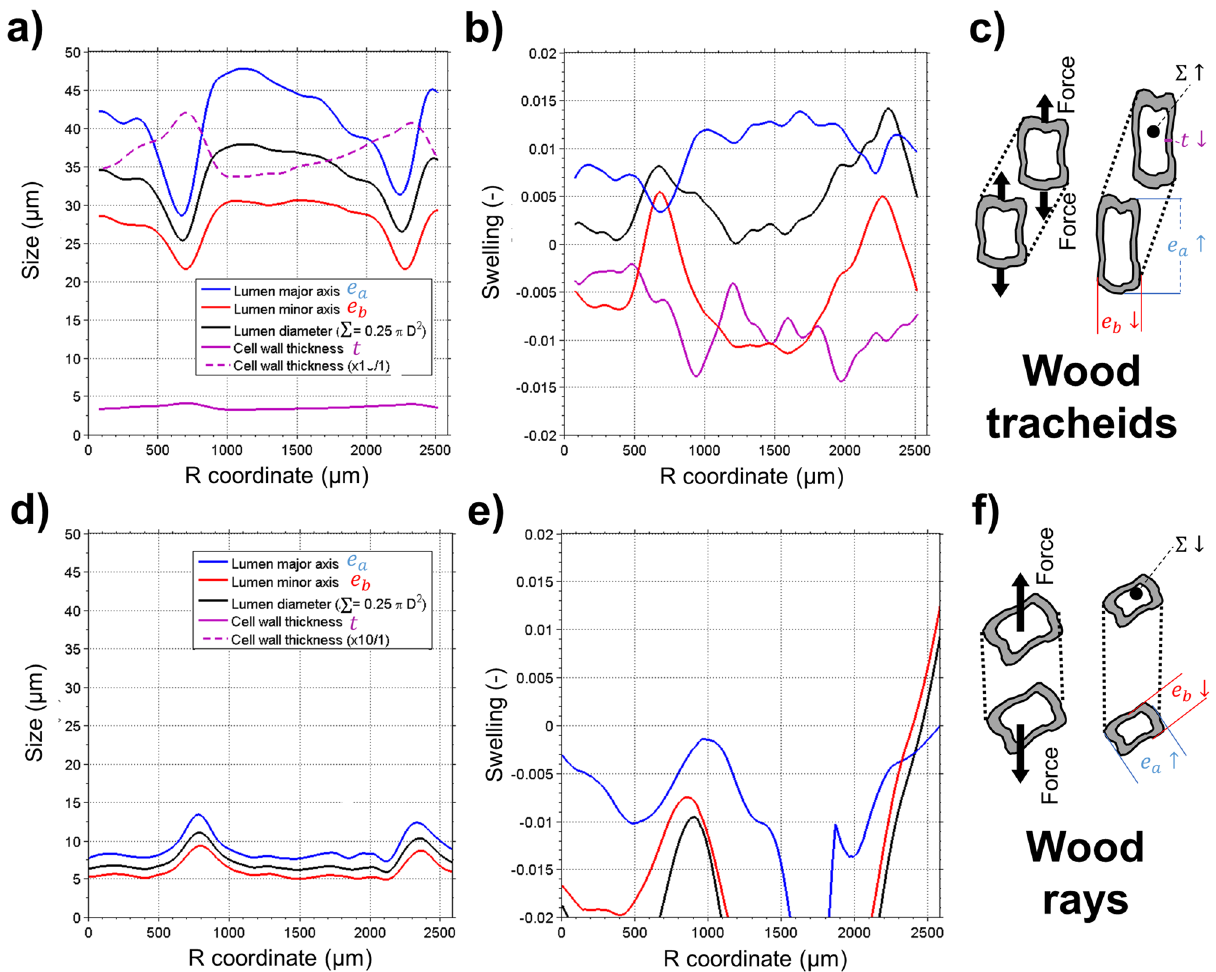
Figure 5. Geometric cell deformation during radial tension experiment (elastic state #2 of Fig. 4). ( a ) shows cell dimensions, ( b ) strains and ( c ) deformation schematic for wood tracheids. Due to tension in R and Poisson effect in T, tracheid lumen’s major axis e a expands and minor axis e b compresses; with strains along the growth ring following ε RR and ε TT , respectively (Fig. 4). An overall increase of lumen area (cid:31) is observed, with a corresponding thinning of the cell wall t . ( d ) shows cell dimensions, ( e ) strains and ( f ) deformation schematic for wood rays. Due to tension in R and Poisson effect in T and L, both major e a and minor e b cell axes compress, with an overall decrease of lumen area (cid:31)